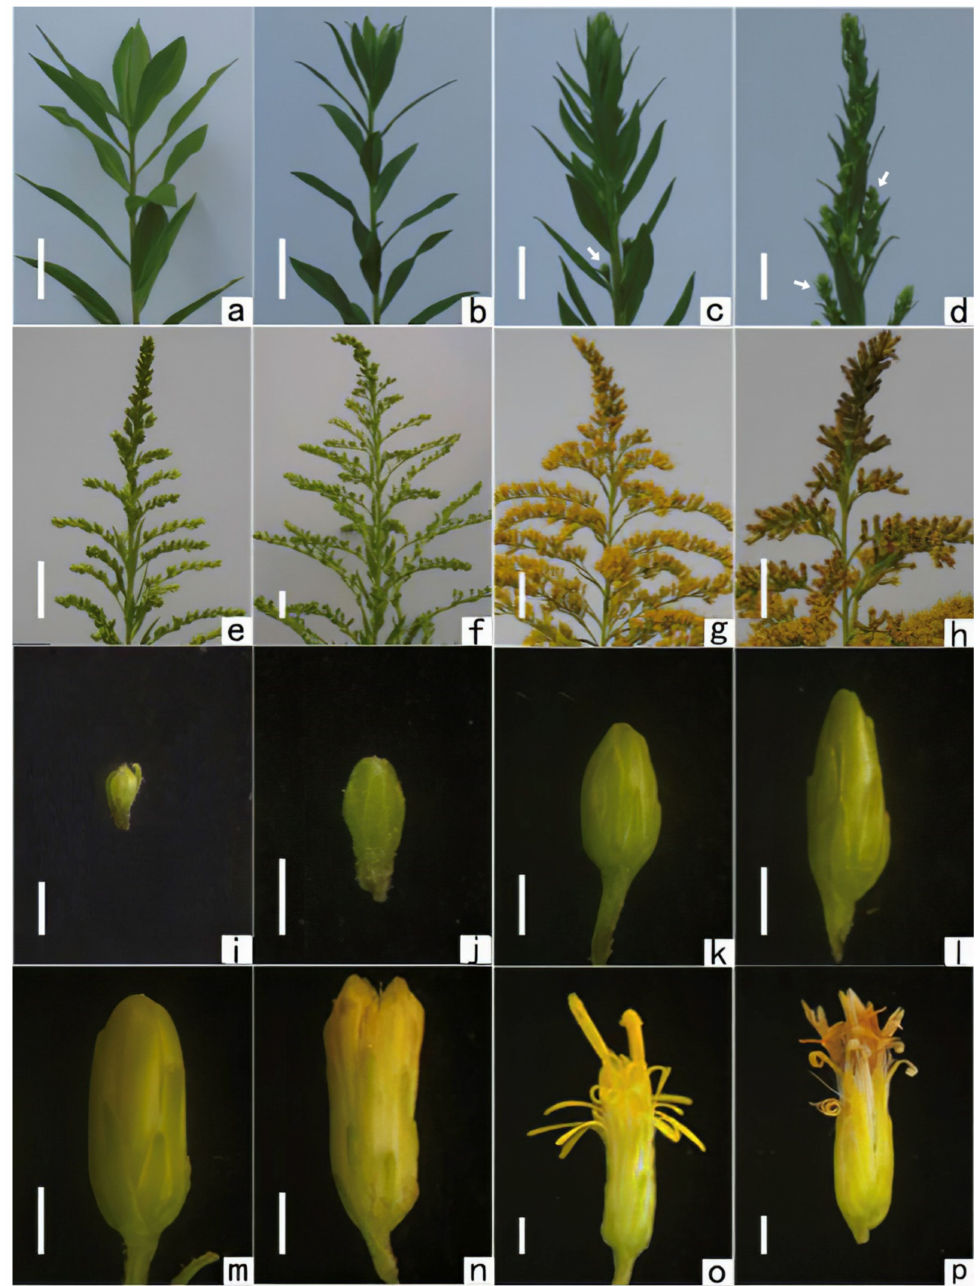
Figure 1. Plant and capitulum morphologies during the reproductive growth of S. canadensis (pop- ulation number: CN04). ( a ) Plant in the vegetative growth stage. ( b ) Plant in the late vegetative growth stage. ( c ) Capitulum bud (arrowhead) occurrence in the axillary buds on the short branches. ( d ) End of capitulum development (arrowheads) on the top of the plant. ( e ) Developing panicle. ( f ) Completely developed panicle. ( g ) Flowering panicle. ( h ) Withering panicle. ( i ) Capitulum during capitulum development. ( j ) Capitulum with a completely differentiated capitulum bud. ( k ) Capitulum during the microsporocyte stage. ( l ) Capitulum during the microspores meiosis stage. ( m ) Capitulum during the developing-male-gametophyte stage. ( n ) Capitulum with mature pollen. ( o ) Flowering capitulum. ( p ) Withering capitulum. Scale bars: a–d = 2 cm, e–h = 5 cm, i–p = 1 cm. According to the morphological characteristics, the capitulum development of